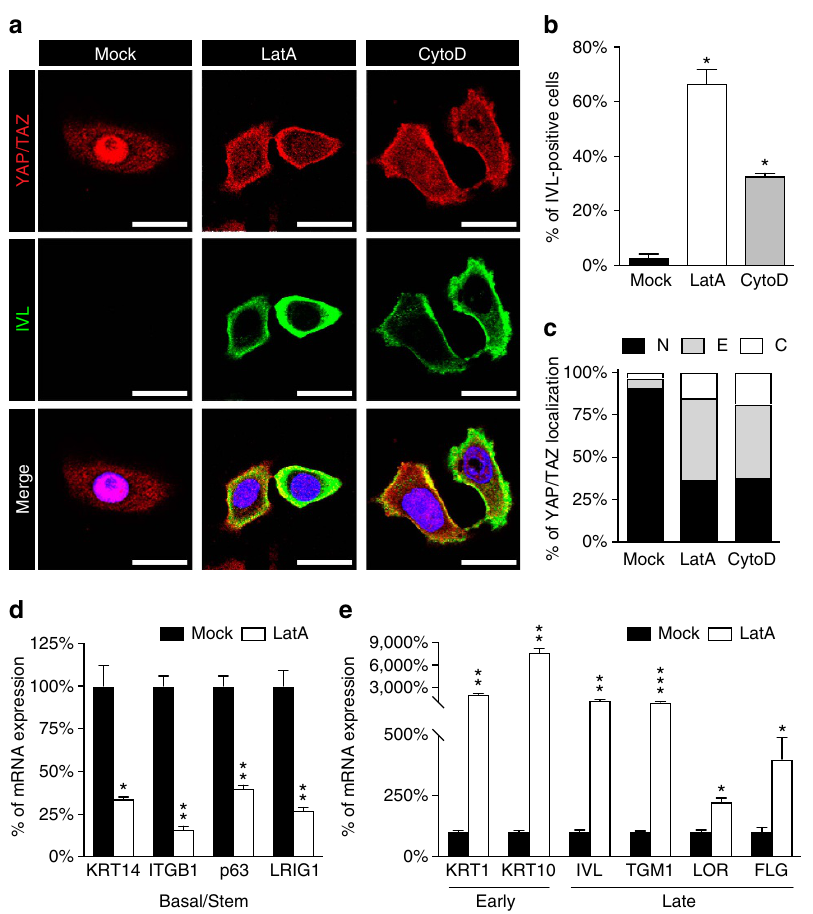
Figure 3 | F-actin preserves epidermal stemness by sustaining YAP/TAZ and opposing differentiation. ( a ) IF microscopic images of nHEK cells treated for 24h with vehicle (Mock), 0.8 m M latrunculin A (LatA) or 2.5 m M cytochalasin D (CytoD). Images show the endogenous YAP/TAZ proteins (red) and the Involucrin differentiation marker (IVL, green). DAPI (blue) is a nuclear counterstain. Scale bar: 20 m m. ( b ) Quantitation of Involucrin expression after treatment for 24h with actin inhibiting drugs as in a . Bars represent mean þ s.d. ( n ¼ 3 independent experiments. * P o 0.0001 compared to Mock-treated cells; Student’s t -test). ( c ) Proportion of YAP/TAZ subcellular distribution in nHEK cells treated with the indicated drugs and analysed as previously described. Bars represent mean of three independent experiments. ( d , e ) nHEK cells treated for 24h with vehicle (Mock) or 0.8 m M latrunculin A (LatA) were analysed by qRT–PCR for the expression of either basal and stem marker genes ( KRT14 , ITGB1 , p63 , LRIG1 ) ( d ) or early ( KRT1 , KRT10 ) and late ( IVL , TGM1 , LOR , FLG ) differentiation genes ( e ). Notably, LatA potently promoted differentiation as shown by the upregulation of the indicated markers. At the same time, disrupting F-actin integrity is sufficient to reduce the expression of basal ( KRT14 ) and SC ( ITGB1 , p63 and LRIG1 ) markers. Bars represent mean þ s.d. * P o 0.05, ** P o 0.01, *** P o 0.001 compared to Mock; Student’s t -test). See Methods section for reproducibility of experiments. See also Supplementary Fig. 2g for the effect of F-actin-inhibiting drugs on YAP/TAZ transcriptional activity in keratinocytes.